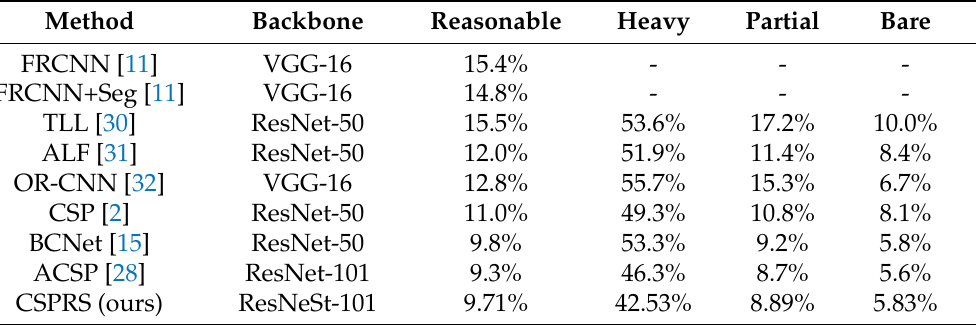
Table 3. Comparisons with state-of-the-art on the reasonable, heavy, partial and bare sets of the CityPersons